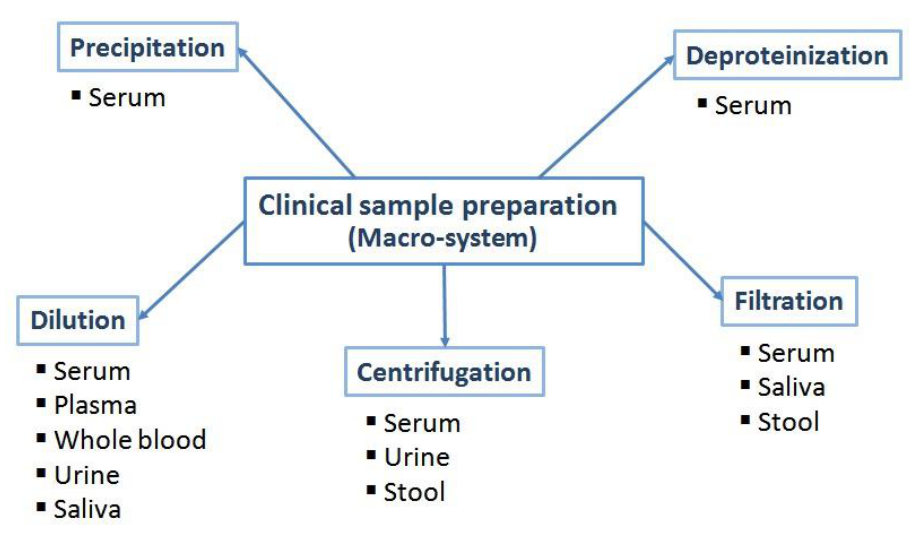
Figure 1. Summary of the most often applied macro-system sample preparation procedures for clinical